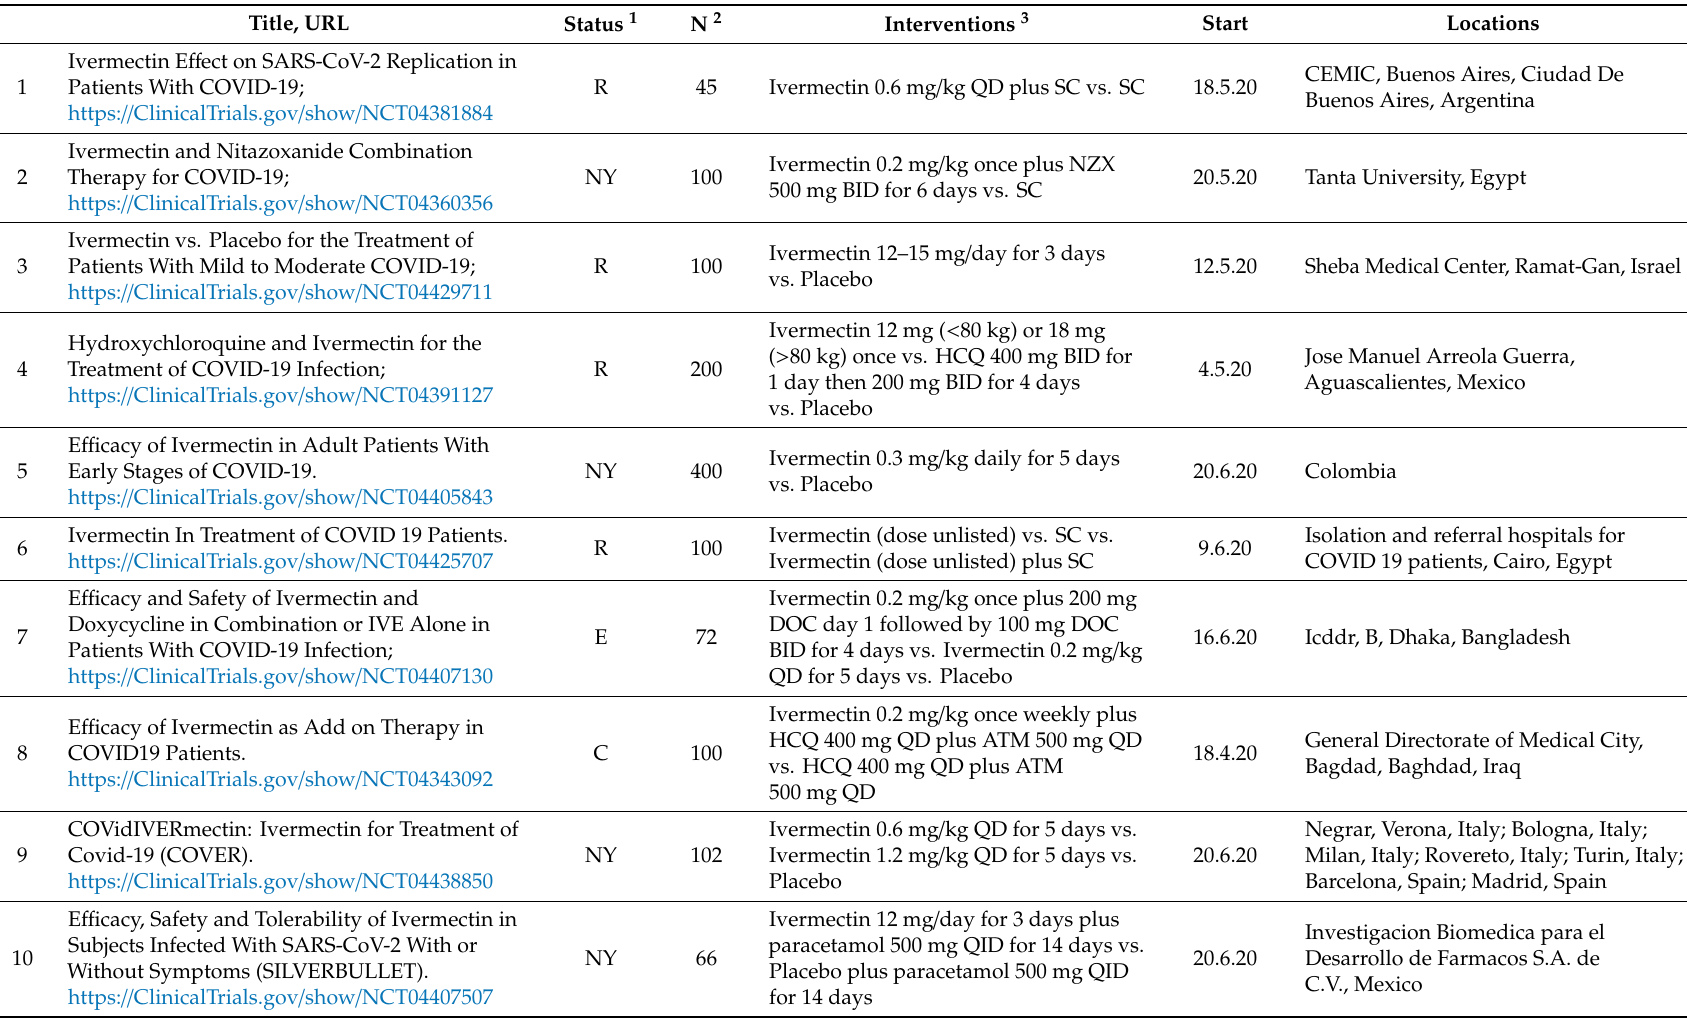
Table 2. Summary of current clinical trials using ivermectin for